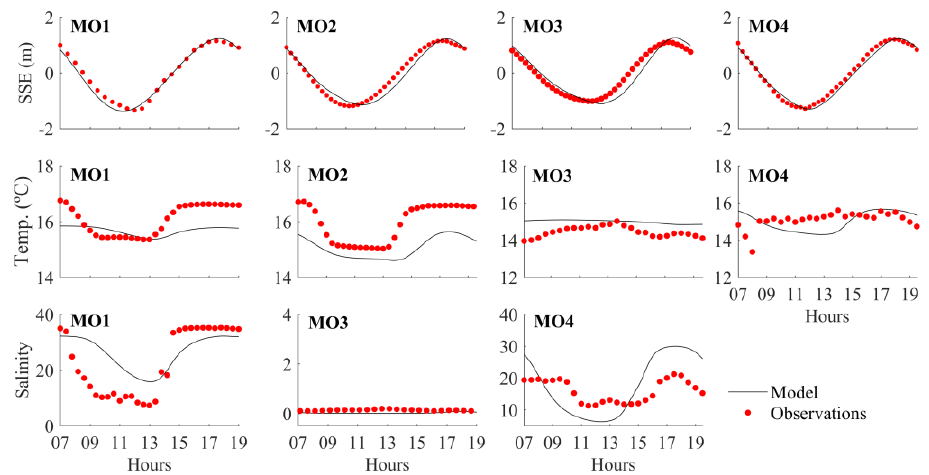
Figure 2. Comparison between model results and observations of sea surface elevation, water temperature, and salinity for MO1, MO2, MO3, and MO4 stations located at Mondego Estuary during the spring tide.